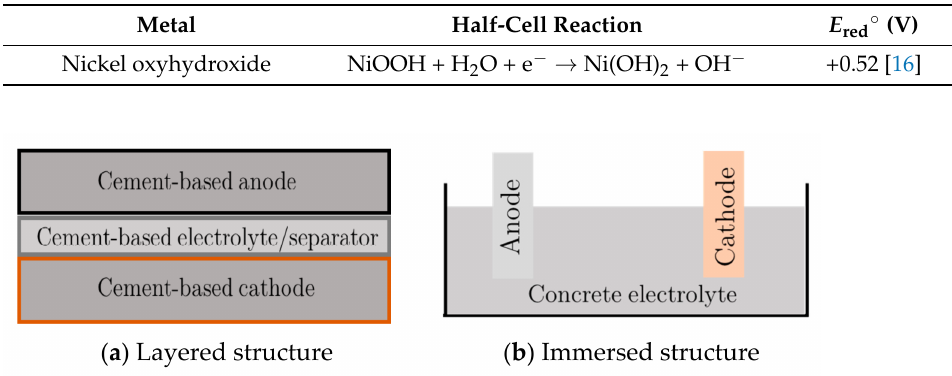
Table 2. Possible cathode materials and their half-cell reactions.